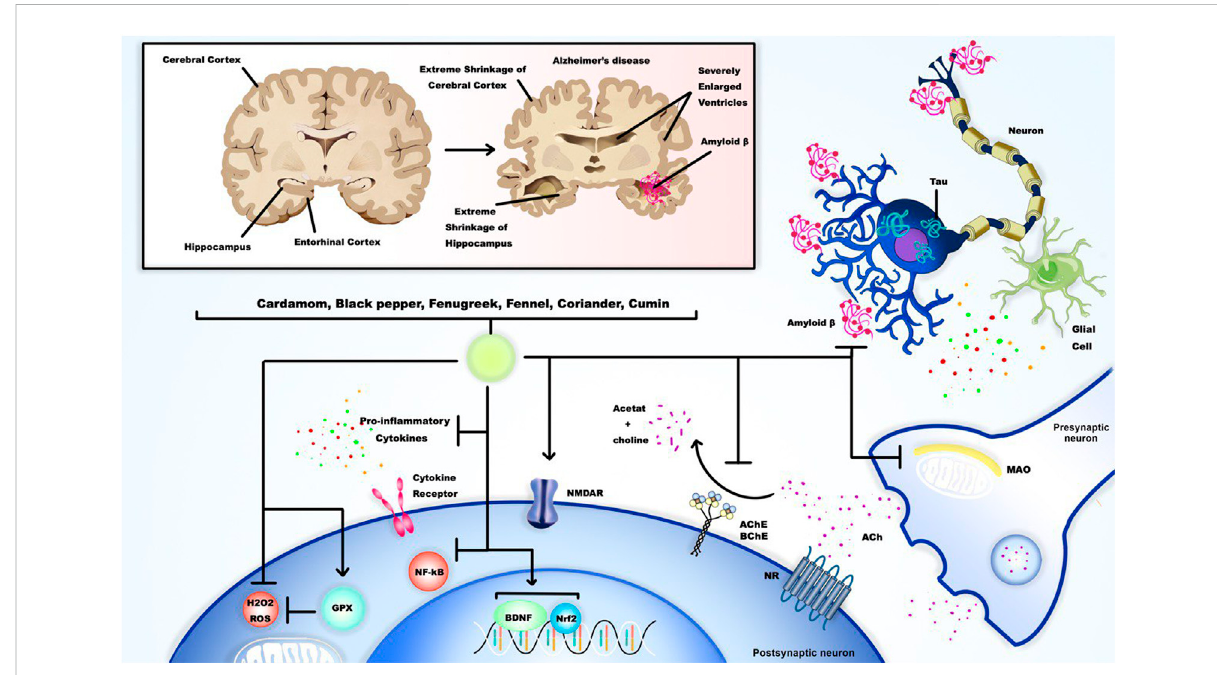
FIGURE 2 Alzheimer ’ s disease (AD), as a neurodegenerative disease, is the most common form of dementia. Common Indian spices such as cardamom, black pepper, fenugreek, fennel, coriander, and cumin all have neuroprotective effects in AD through inhibition of amyloid (A β ) plaques formation, in fl ammation, and NF- κ B pathway, MAO formation, H2O2 and ROS formation, and butyrylcholinesterase (BChE) and acetylcholinesterase (AChE) activity. These components can also induce NMDA (N-methyl-D-aspartate) receptor function, glutathione peroxidase (GPX) activity, and Nrf2 and BDNF